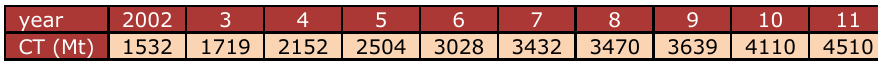
Table 1. The port cargo throughput of nearly 11 years (CT represents Cargo